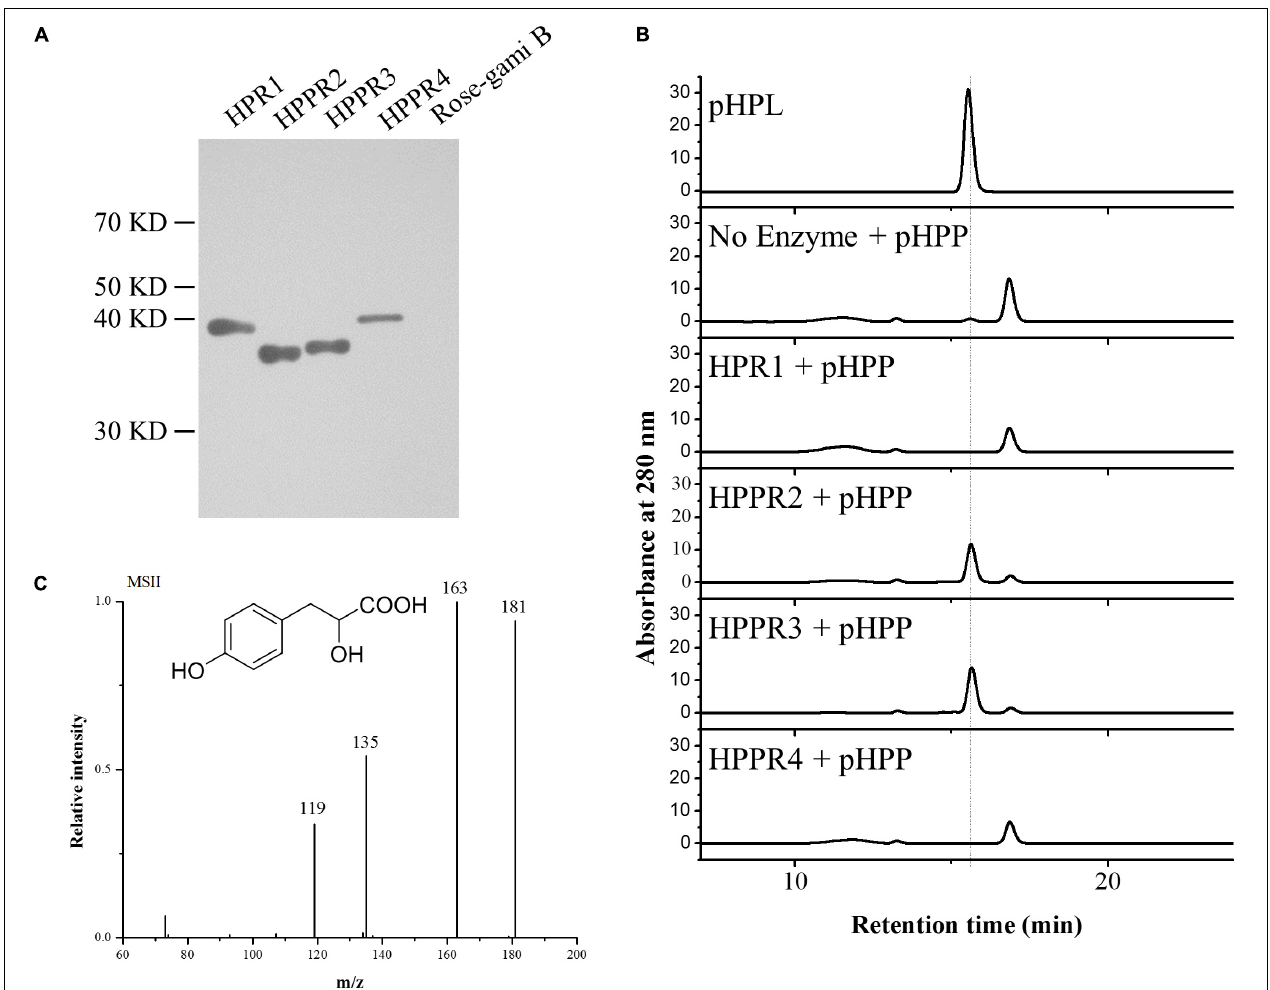
FIGURE 3 | HPPR2 and HPPR3 have HPPR activity in vitro . (A) Western blot analysis of purified recombinant proteins expressed in E. coli using anti-His antibody. (B) HPLC profiles of the pHPL standard and the reaction products after incubation of no enzyme, HPR1, HPPR2, HPPR3, and HPPR4 with pHPP as substrate. (C) Mass spectrum and structure of